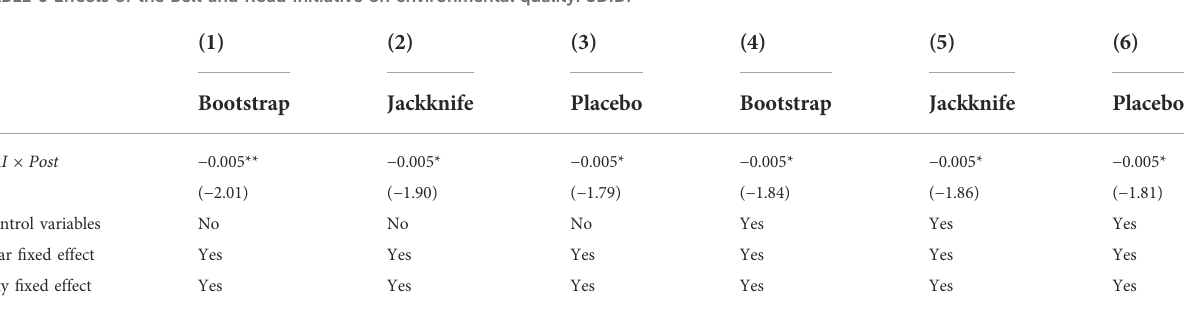
TABLE 6 Effects of the Belt and Road Initiative on environmental quality: